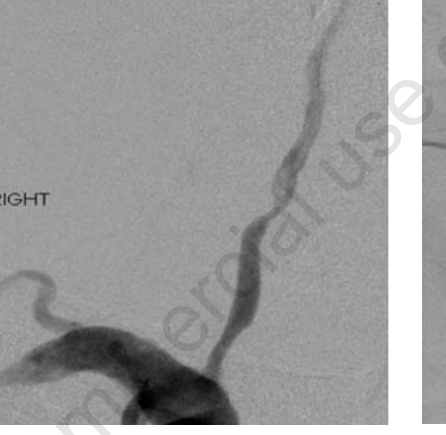
Figure 2. Right vertebral artery. Figure 3. Left internal carotid